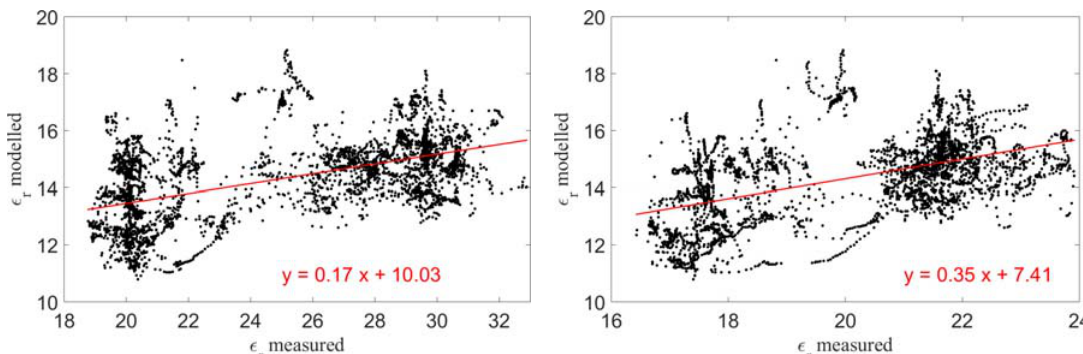
Figure 10. Comparison of the soil relative dielectric permittivities ( ε r ) derived from the radiometer measurements with the in situ ε r measurements at: 3 cm depth ( left ); and 10 cm depth ( right ). Regression lines are based on the robust least absolute residual (LAR) method and their equation are shown in red.